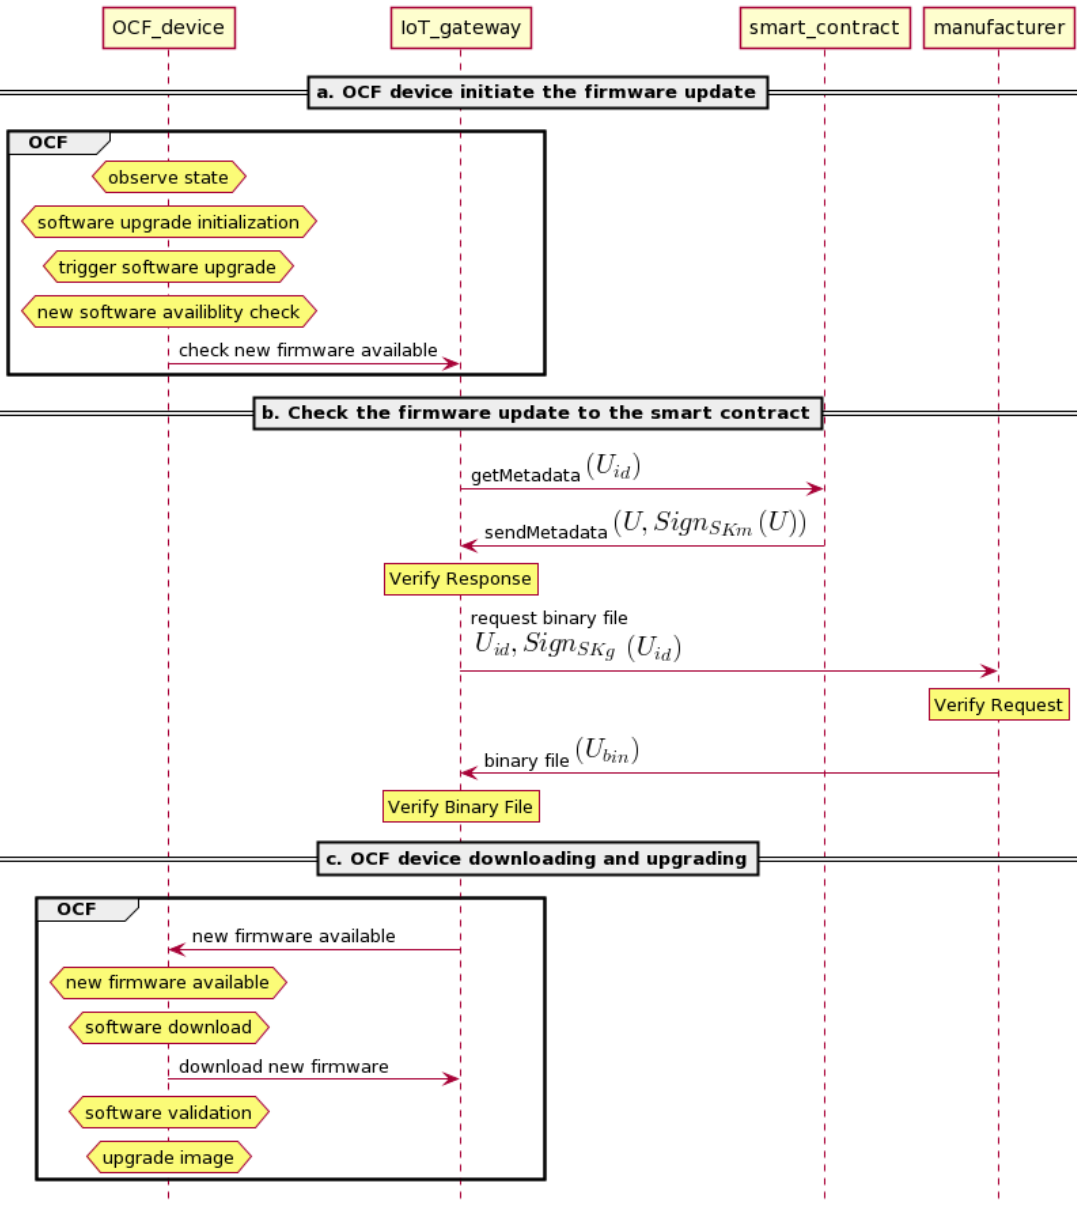
Figure 4. Direct firmware update distribution: gateway downloading a new firmware update from the